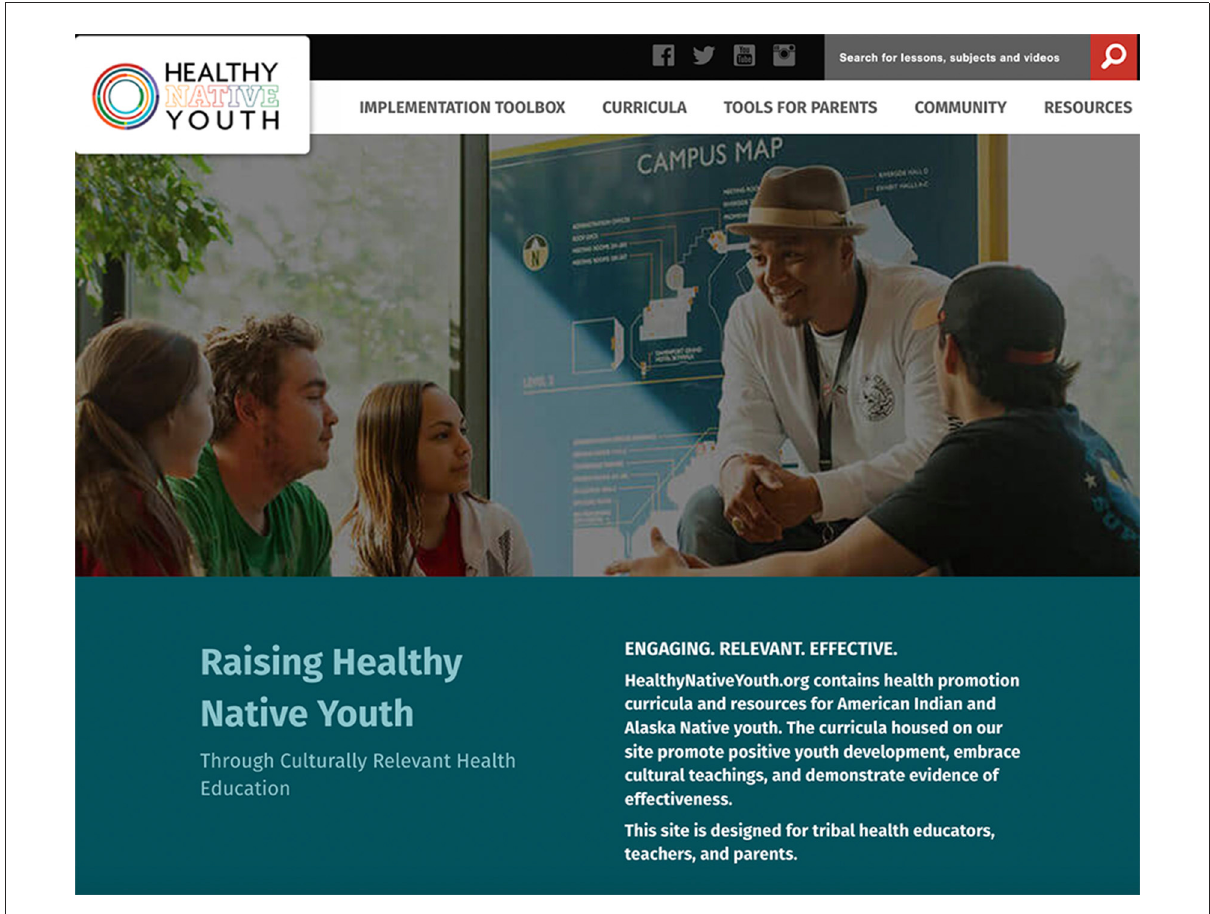
FIGURE5 Screen capture of the Healthy Native Youth website home